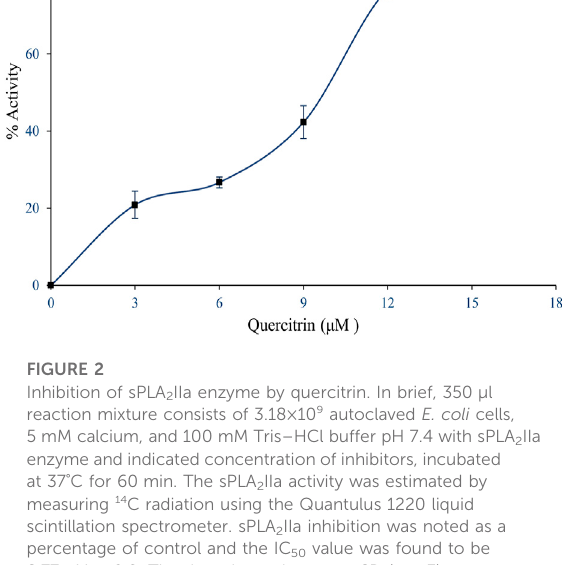
(Table 1). Quercitrin (PubChem ID 5280459) interacts with Ala17, Tyr21, and His47 residues of the sPLA 2 IIa enzyme (H bond).